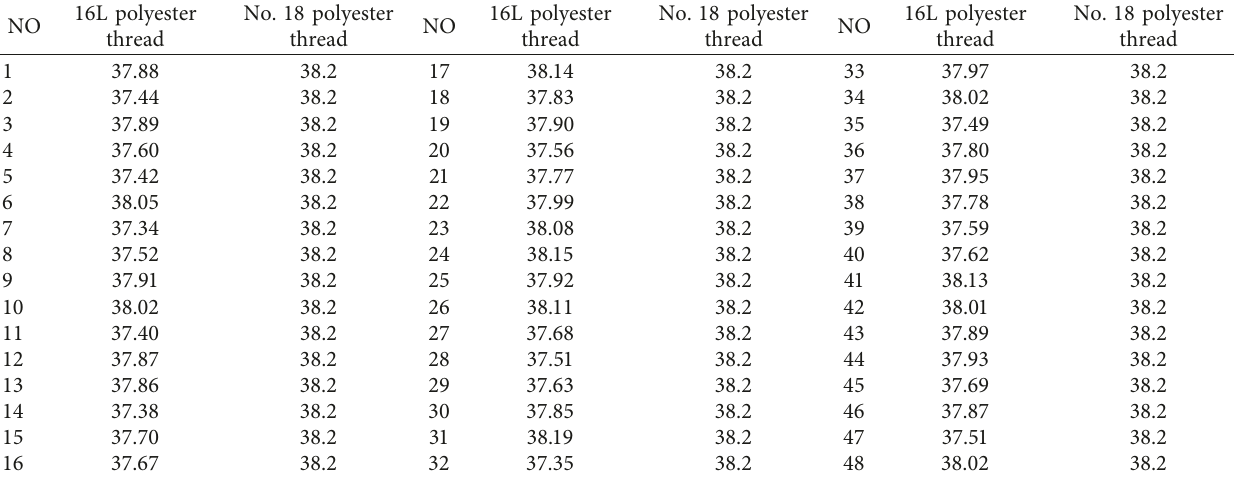
Table 5: The vibration frequency of the racket acceleration and impact of different string diameter groups.